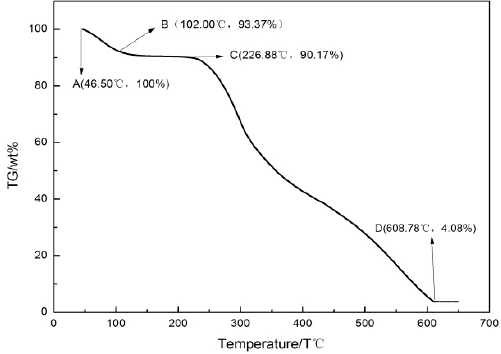
Figure 2. The weight loss curve of the whole DFs.